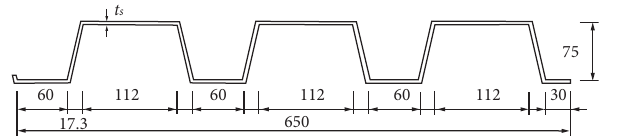
Figure 4: Dimension details of profiled steel sheet.